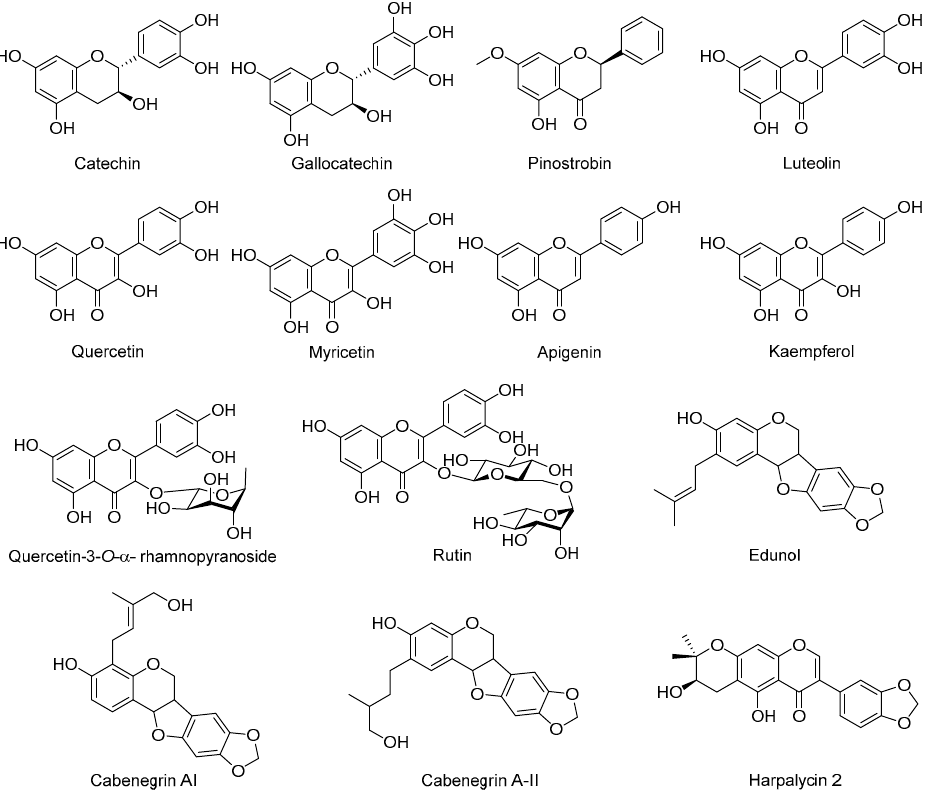
Figure 3. Selected flavonoids with antivenom activity .